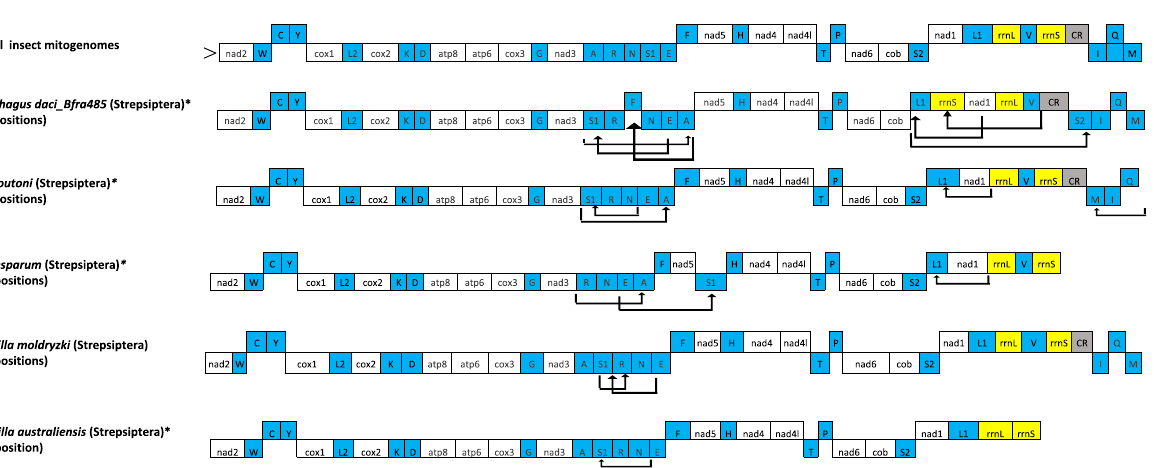
Figure 5. Mitogenome organisation and rearrangement illustrating gene translocations and number of transpositions in Dipterophagus daci and four strepsipteran species relative to the ancestral pattern in insect mitogenomes; tRNA genes are blue, rRNA genes are yellow, protein coding genes are white and the control region is grey. The major (leading) strand is denoted by > , arrows denote gene translocations and * indicate species for which only incomplete mitogenomes are available. Mitogenome representation is not drawn to